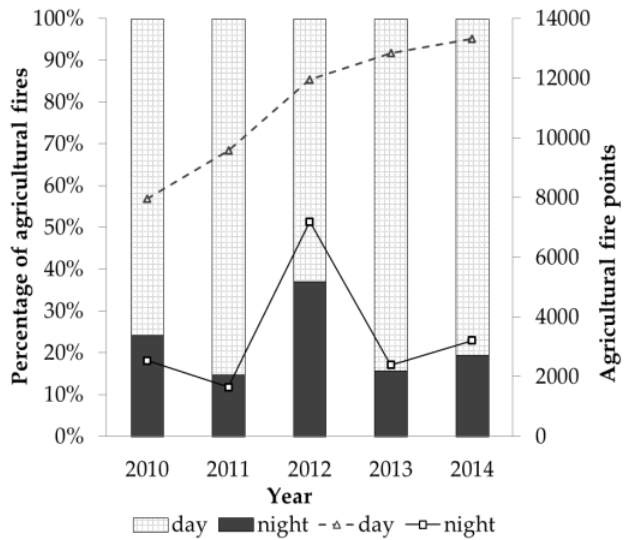
Figure 6. Interannual variations of the percentage of agricultural fires (stacked column chart) and the fire counts (line chart) at different times of the day.